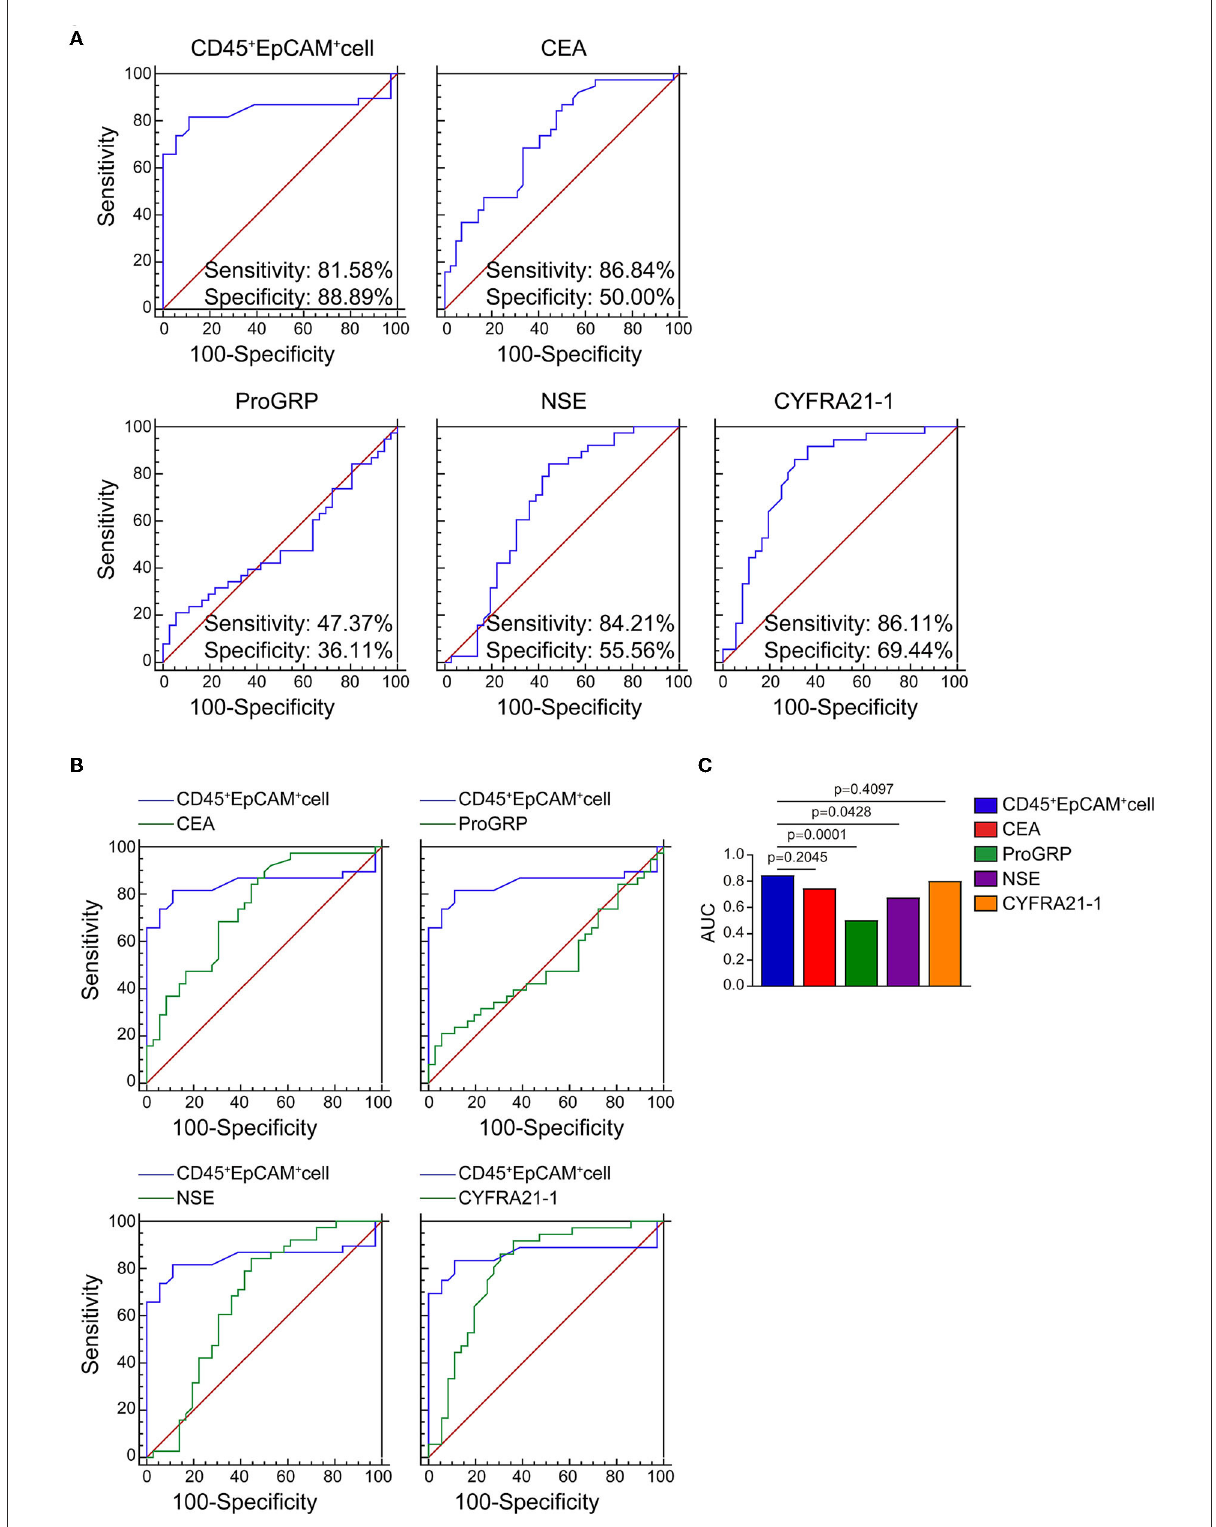
FIGURE3 ROC and AUC analysis of CEA, ProGRP, NSE, CYFRA21-1 serum level and CD45 + EpCAM + cell ratio in PBMCs of lung cancer patients. (A) ROC curve analysis of CEA, ProGRP, NSE, CYFRA21-1 serum level and CD45 + EpCAM + cell ratio (healthy volunteers = 42, patients = 38). (B) The comparison of CEA, ProGRP, NSE, CYFRA21-1 serum level with CD45 + EpCAM + cell ratio in AUC analysis. (healthy volunteers = 36, patients = 38). (C) Statistic summary of AUC analysis of CEA, ProGRP, NSE, CYFRA21-1 serum level and CD45 + EpCAM + cell ratio in PBMCs from health volunteers and lung cancer patients (healthy volunteers = 36, patients =